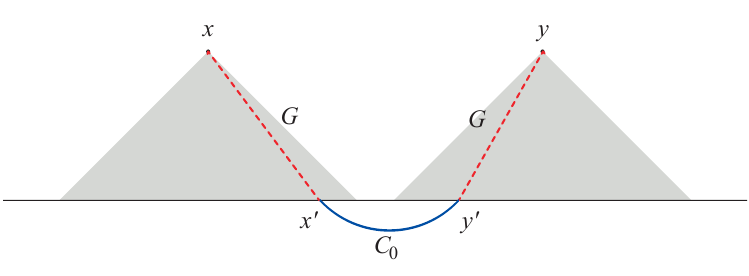
Figure 7 . Schematic explanation of the horizon